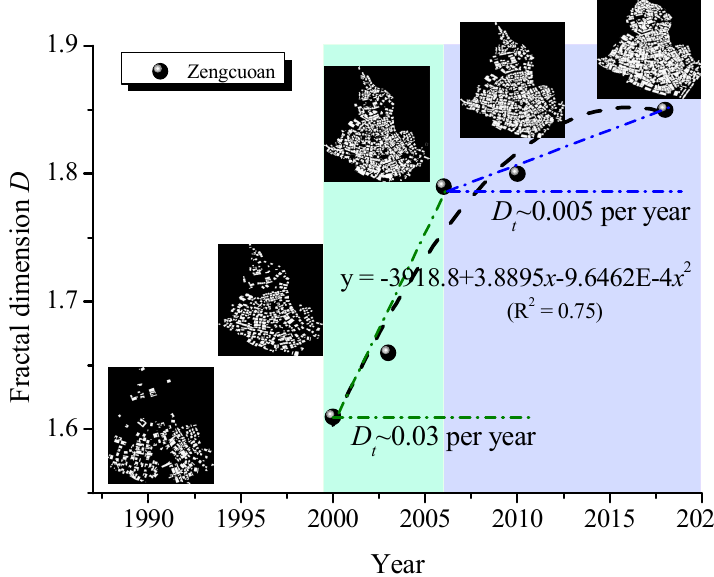
Figure 4. Time evolution of the fractal dimension of Zengcuoan settlement.